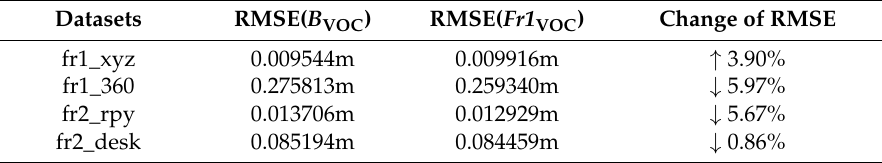
Table 4. The performance tests of small-scale vocabulary in similar